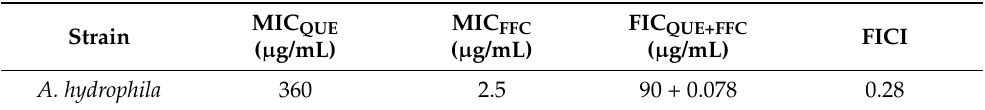
Table 1. Minimum inhibitory concentration (MIC), fractional inhibitory concentration (FIC) and FIC indexes (FICI) of quercetin and florfenicol against A. hydrophila.